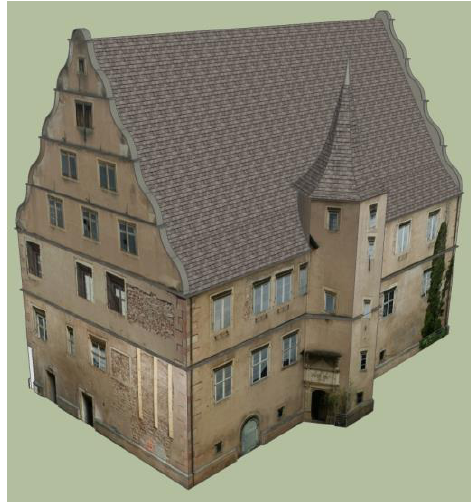
Figure 2.c: Textured CAD model